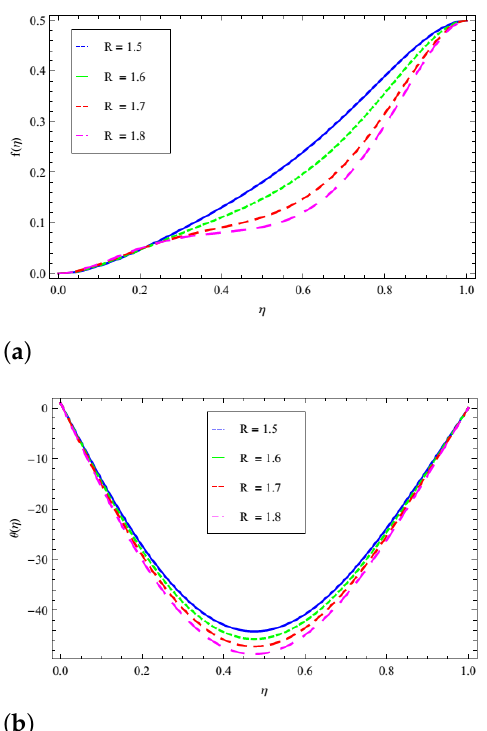
Figure 8. Impact of R on ( a ) velocity component along x-axis f ( η ) and ( b ) heat distribution variable